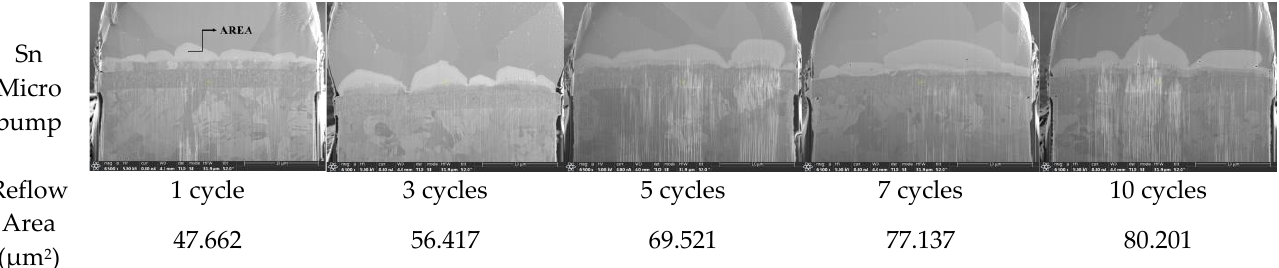
Figure 12. IMC area cross-section graph by the number of reflows.